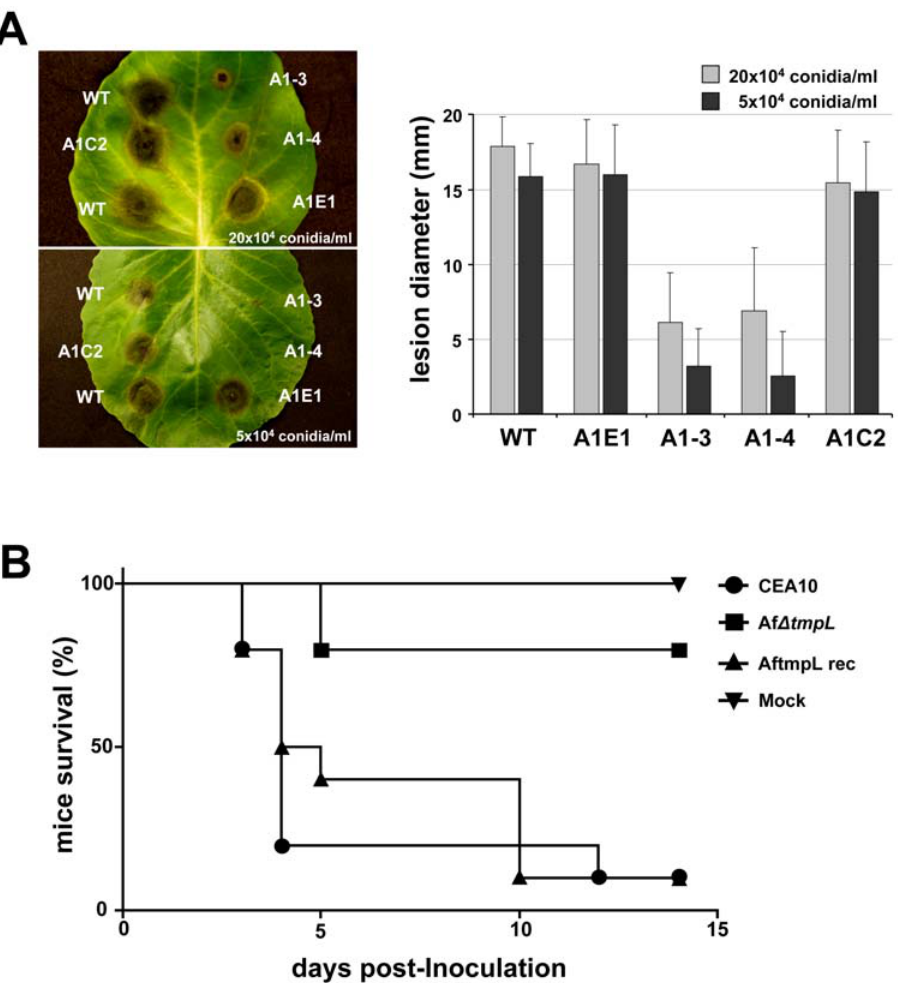
Figure 9. Reduced virulence of D tmpL mutants. ( A ) Virulence assay on green cabbage leaves using two conidial concentrations, 20 6 10 4 and 5 6 10 4 conidia ml 2 1 of A. brassicicola wild-type (WT), ectopic (A1E1), two D tmpL mutants (A1–3 and A1–4), and a reconstituted strain (A1C2). Five days after inoculation (graph), disease severity was calculated based on the lesion diameter. Columns and error bars represent average and SD, respectively, of five independent experiments. ( B ) Virulence assay on mice mock inoculated or inoculated intranasally with 10 6 conidia/ 25 m l of A. fumigatus wild-type (CEA10), D tmpL mutant (Af D tmpL ), and reconstituted strain (AftmpL rec). P value for comparison between Af D tmpL mutant and wild-type CEA10, P =0.0006. Af D tmpL is significantly less virulent than the wild-type CEA10 and the reconstituted strain AftmpL